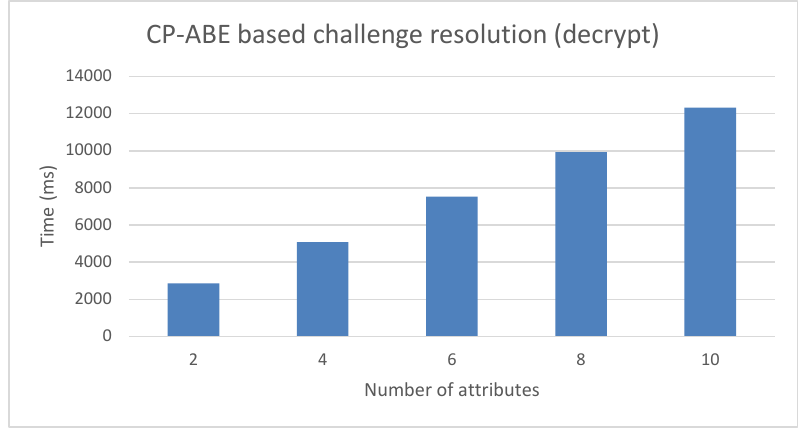
Figure 9. CP-ABE based Anonymous DCapBAC. Challenge resolution